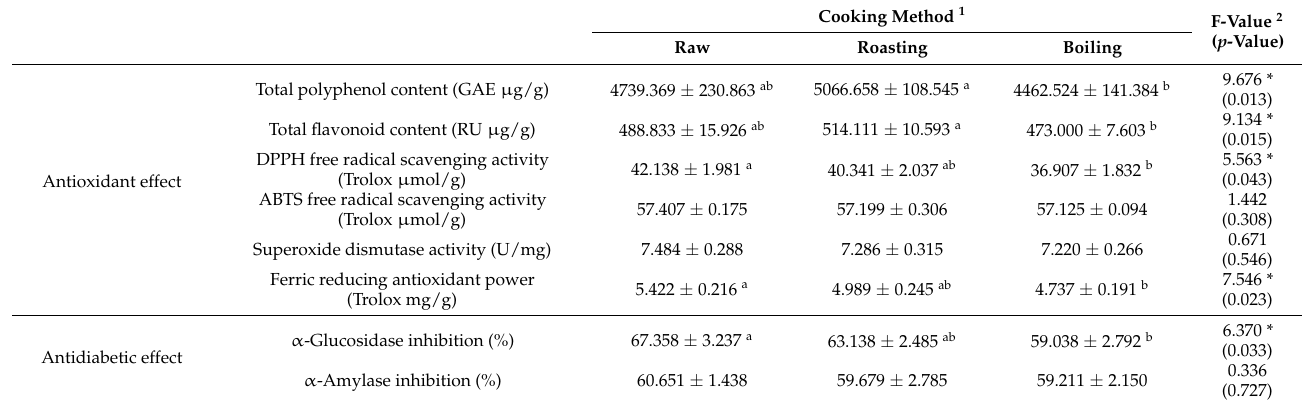
Table 3. Physicochemical effects of raw, roasted, and boiled Tonka beans.